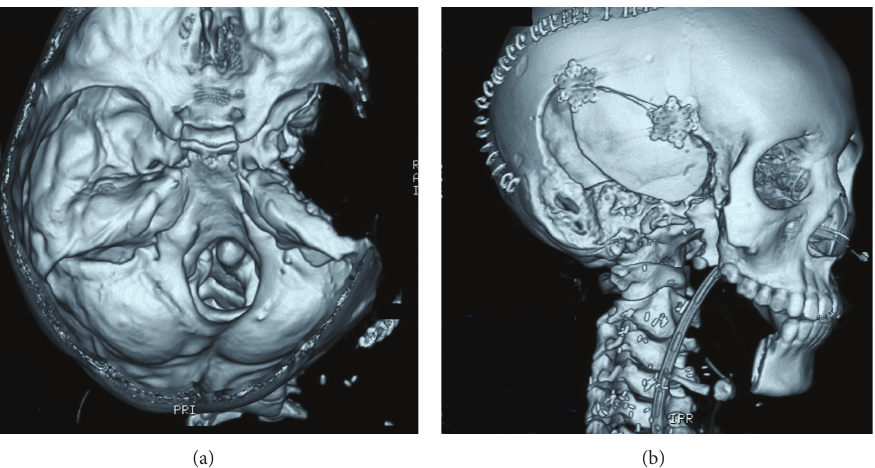
Figure 3: Postoperative 3D CT. The temporomandibular joint capsule, external auditory meatus, and mandibular dissection were removed. The inner ear was retained.